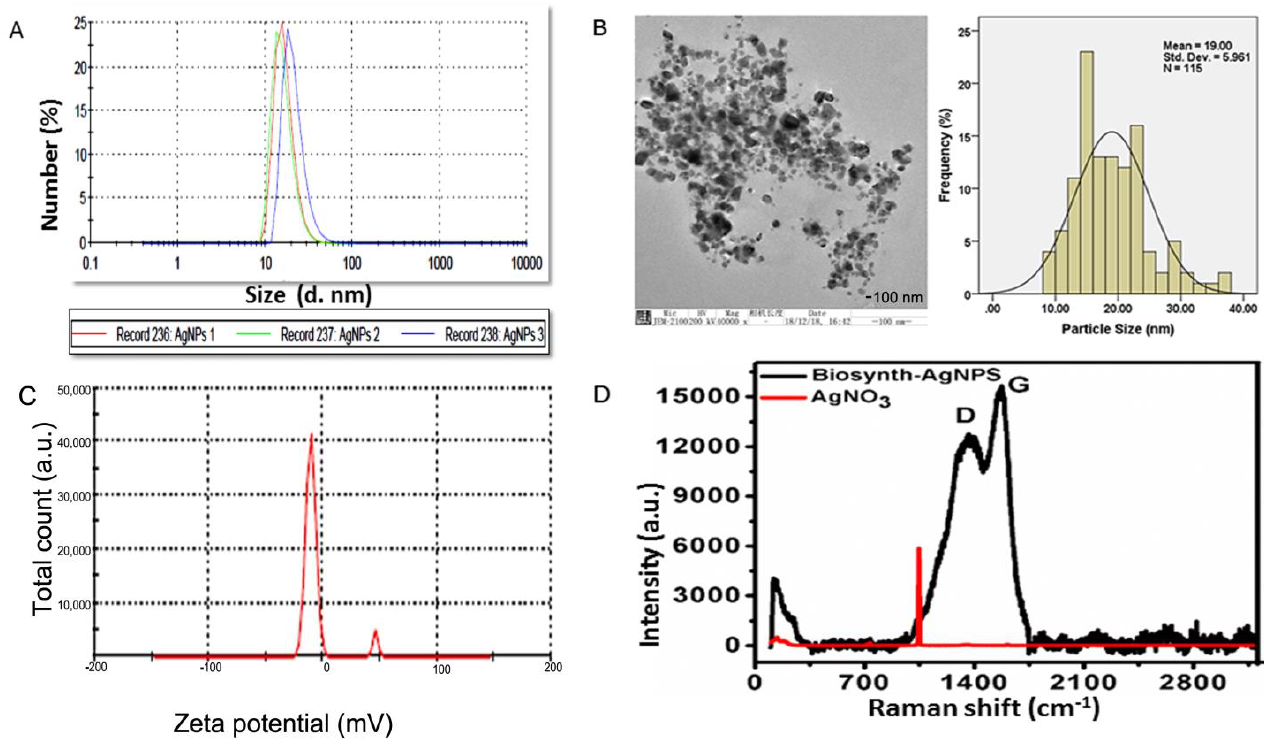
Figure 2. Biogenic AgNPs ’ characterization: ( A ) DLS peak showing different sizes, with % values, ( B ) TEM image with distribution curve, ( C ) zeta potential of biogenic materials, and ( D ) Raman spectra of biogenic materials and control silver nitrate.